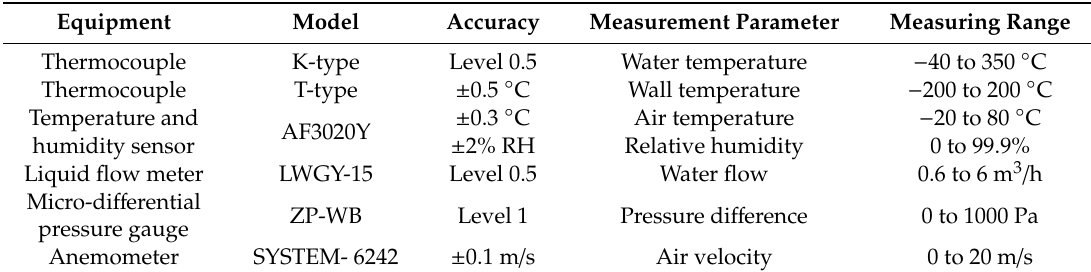
Table 1. Specifications of measurement instruments.